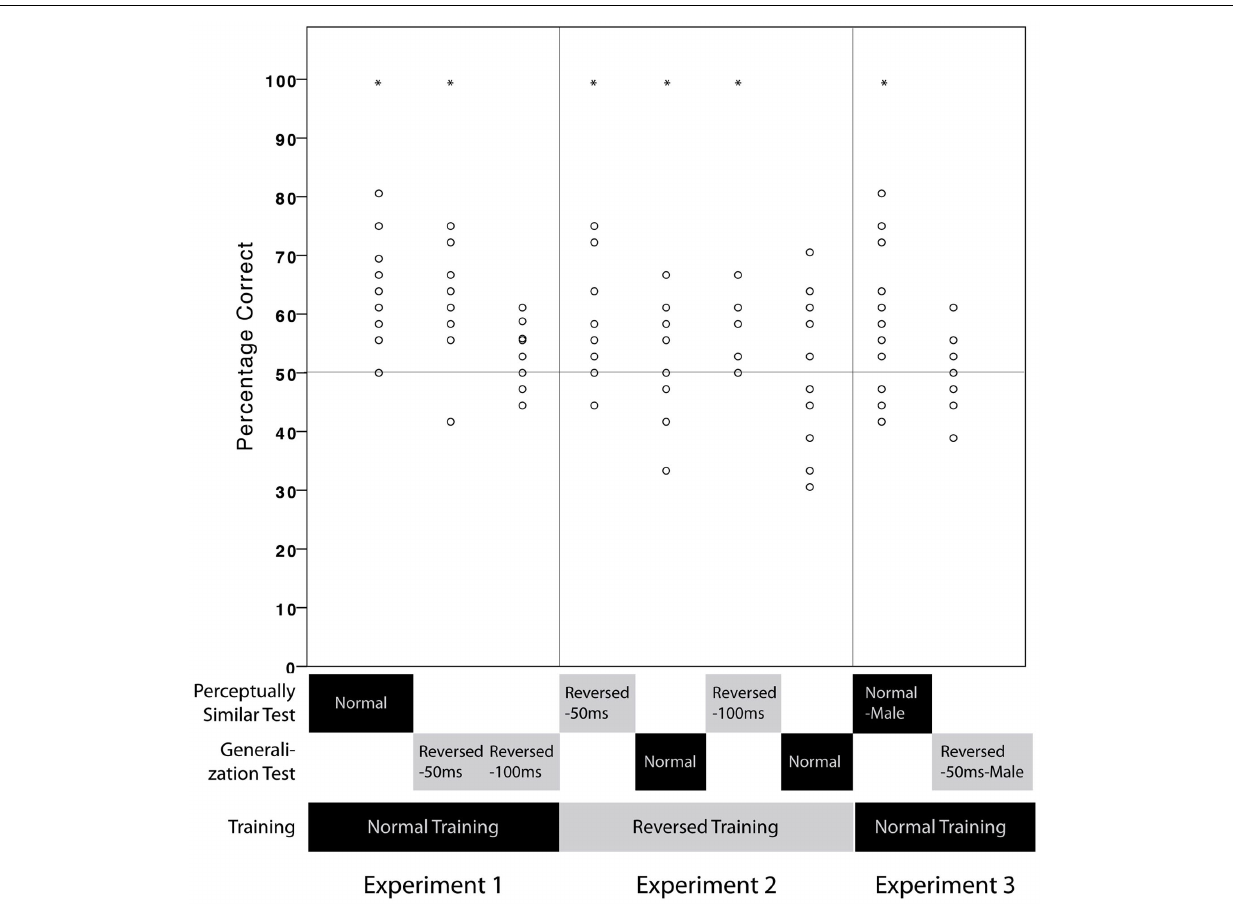
FIGURE 2 | Mean percentage correct for participants in each Experimental condition. Training conditions are indicated in the lower boxes: normal training and test conditions are indicated in light text on a dark frame. Reversed training and test conditions are indicated in dark text on a light